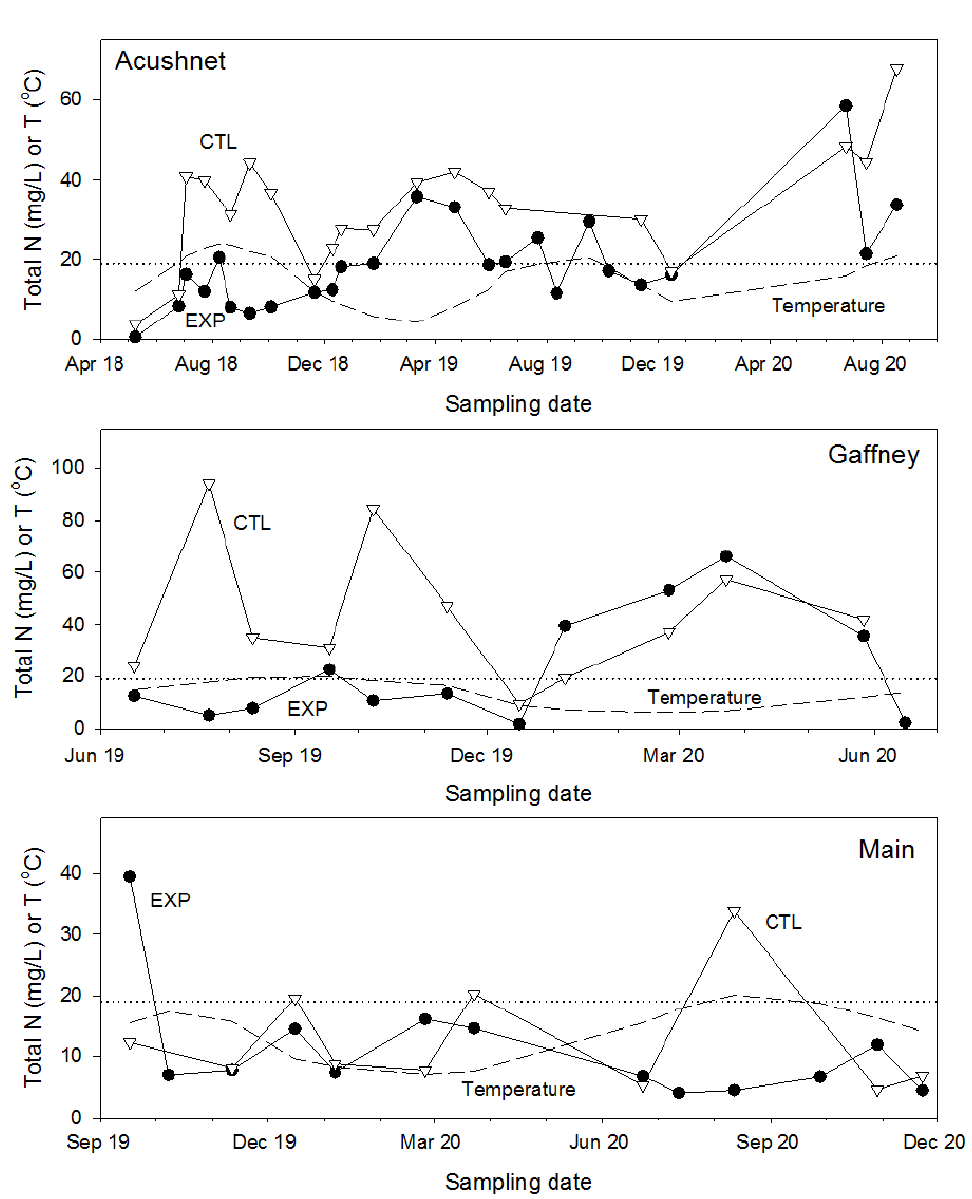
Figure 5. Total nitrogen concentration and temperature of effluent from the sawdust–amended (EXP) and unamended (CTL) sides of the soil treatment area for continuously–occupied systems. Dotted line indicates 19 mg TN/L standard.